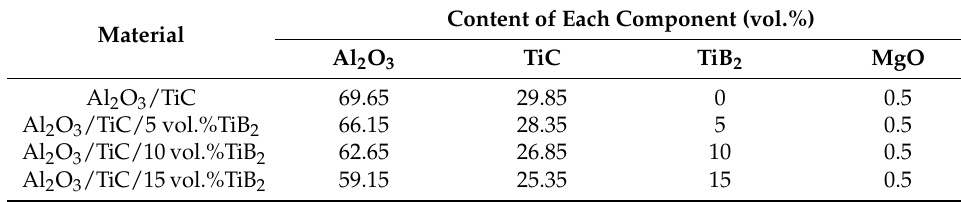
Table 2. The content of the ceramic tool